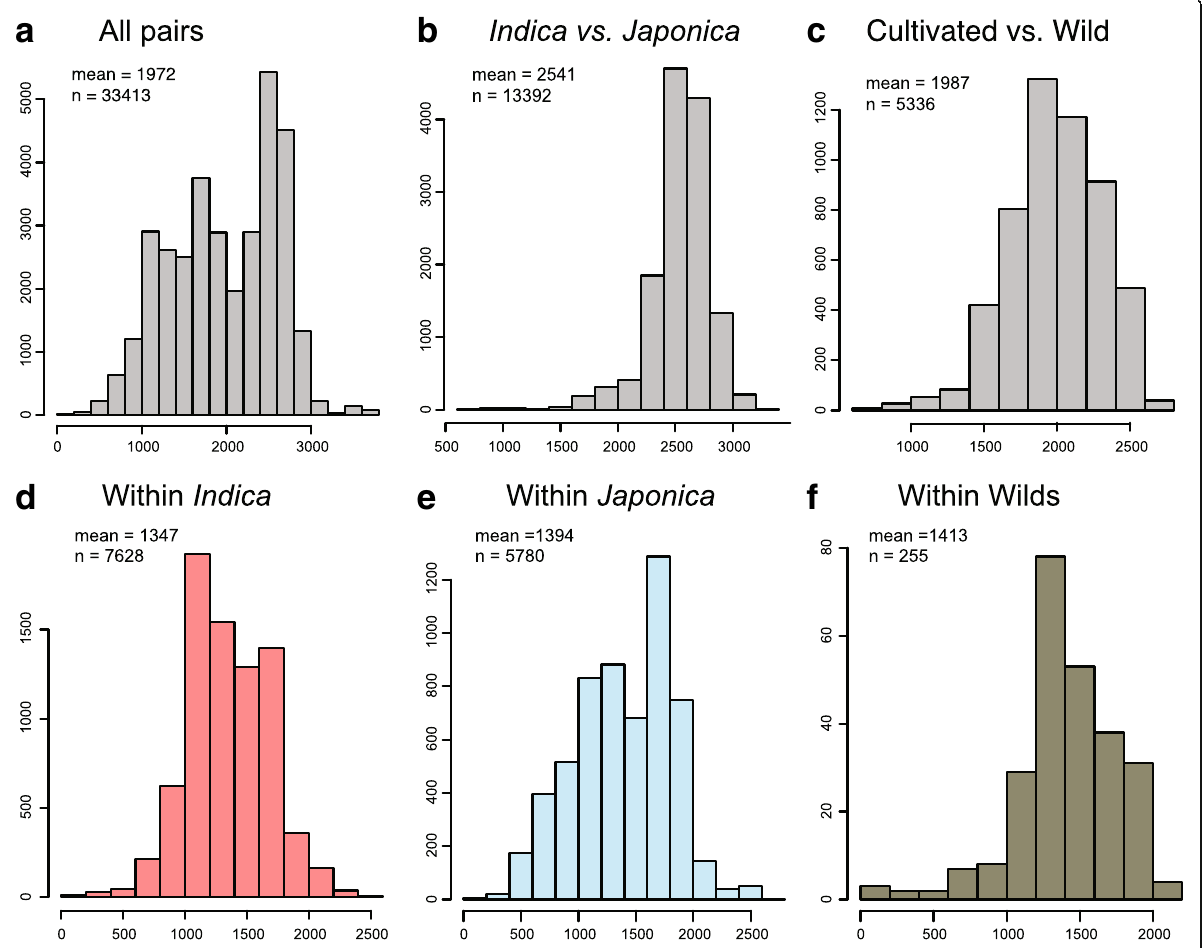
Fig. 2 Distribution of the number of polymorphic markers found in pairwise comparisons across diverse germplasm. The number of polymorphic SNPs/pairwise comparison is shown along the x-axis and its count along the y-axis. Panels display the following groups: a All pairwise comparisons ( n = 33,413), b Indica vs. Japonica accessions ( n = 13,392), c Cultivated vs. wild accessions ( n = 5336), d Indica vs. Indica accessions ( n = 7628), e Japonica vs. Japonica accessions ( n = 5780), and f Wild vs. wild accessions ( n = 255). The mean polymorphic SNPs/pairwise comparison are: 1972 (all pairs), 2541 ( Indica vs. Japonica ), 1987 (cultivated vs. wild), 1347 (within Indica ), 1394 (within Japonica ), 1413 (within